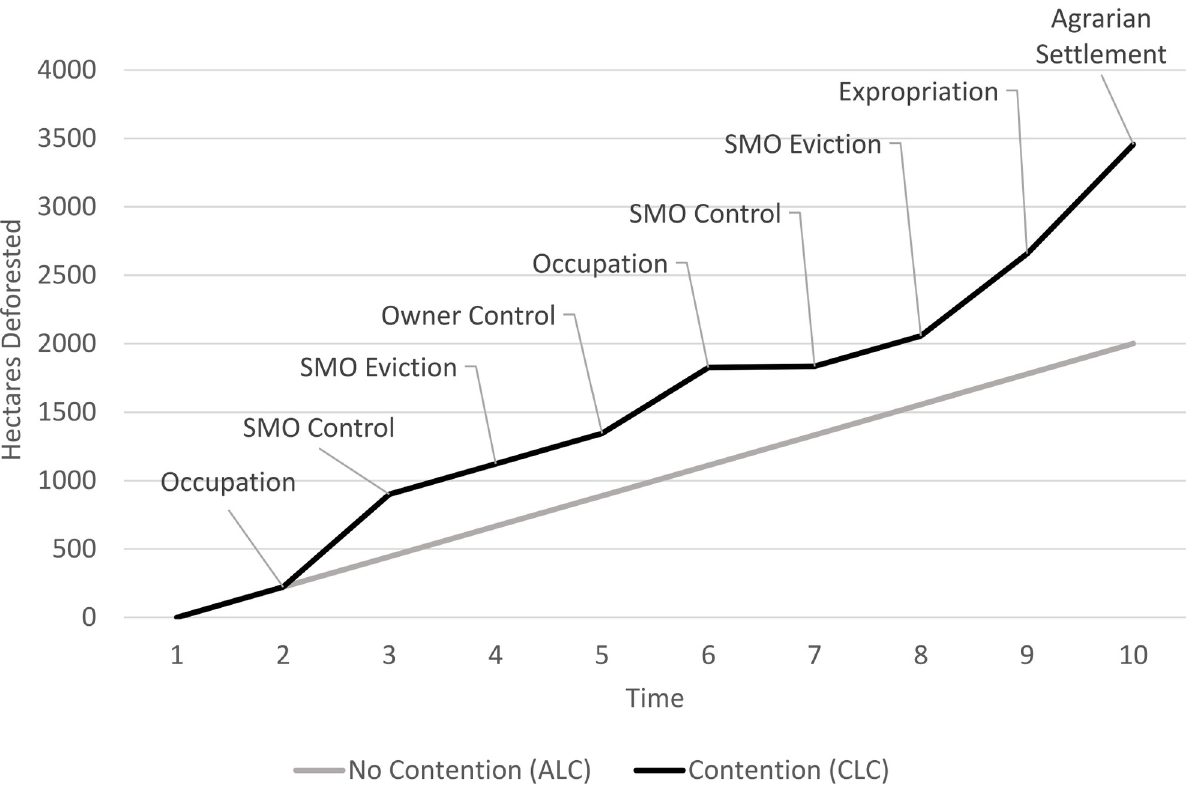
Fig 2. Deforestation trajectories on landholdings under ALC and